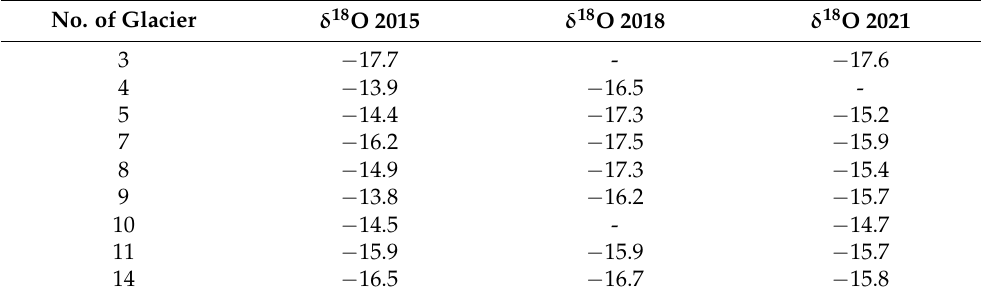
Table 3. Meltwater δ 18 O for glaciers at the northern slope of the Tavan-Bogd massif. No of Glacier